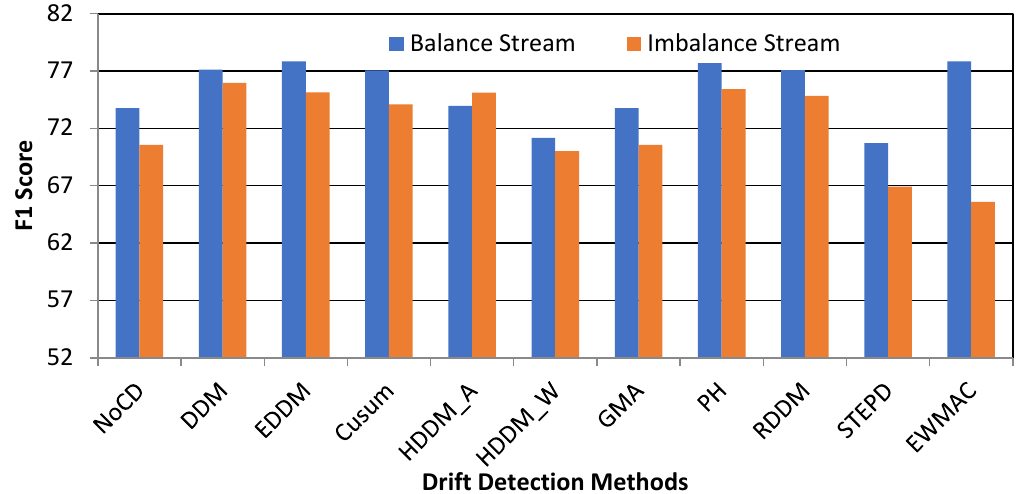
Figure 6. F1 score on balanced and imbalanced data streams with gradual drift.